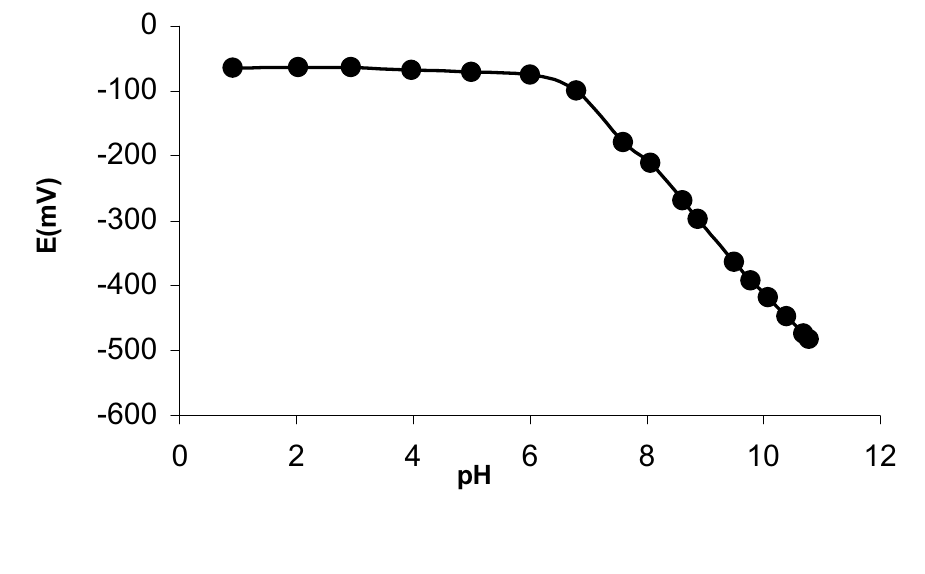
Figure 2. Plot showing the variation of membrane potential with pH at 1.0 × 10 -2 M Ag +